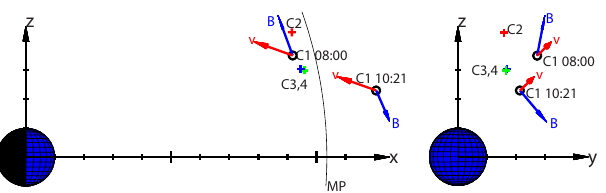
Figure 8. Position of the Cluster spacecraft relative to the planet on 15 March 2007. The Cluster 1 positions are marked “ ◦ ” for the times 08:00 and 10:21, and the positions of the other three spacecraft at 08:00 are marked “+”: red for C2, green for C3, and blue for C4. The blue arrows show the direction of the magnetic field and the red arrows show the plasmoid velocity direction for the plasmoids encountered by C1 at 08:00 and 10:21. The magnetic field direction shown is the mean value in the period from 60 to 30s before the plasmoid arrived at the spacecraft. The left-hand panel shows the x – z plane in GSE coordinates and the right-hand panel shows the y – z plane. The dashed black curve in the left panel shows a Shue model magnetopause.